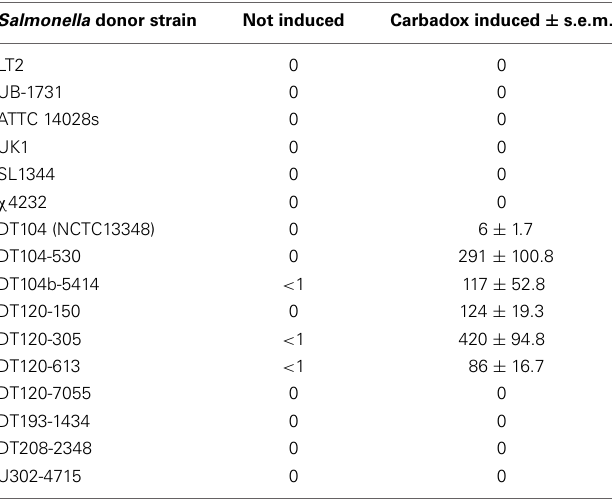
Table 3 | Average frequency of generalized transduction per 0.5ml of lysate from numerous S. Typhimurium donor strains into BBS 243. Salmonella donor strain Not